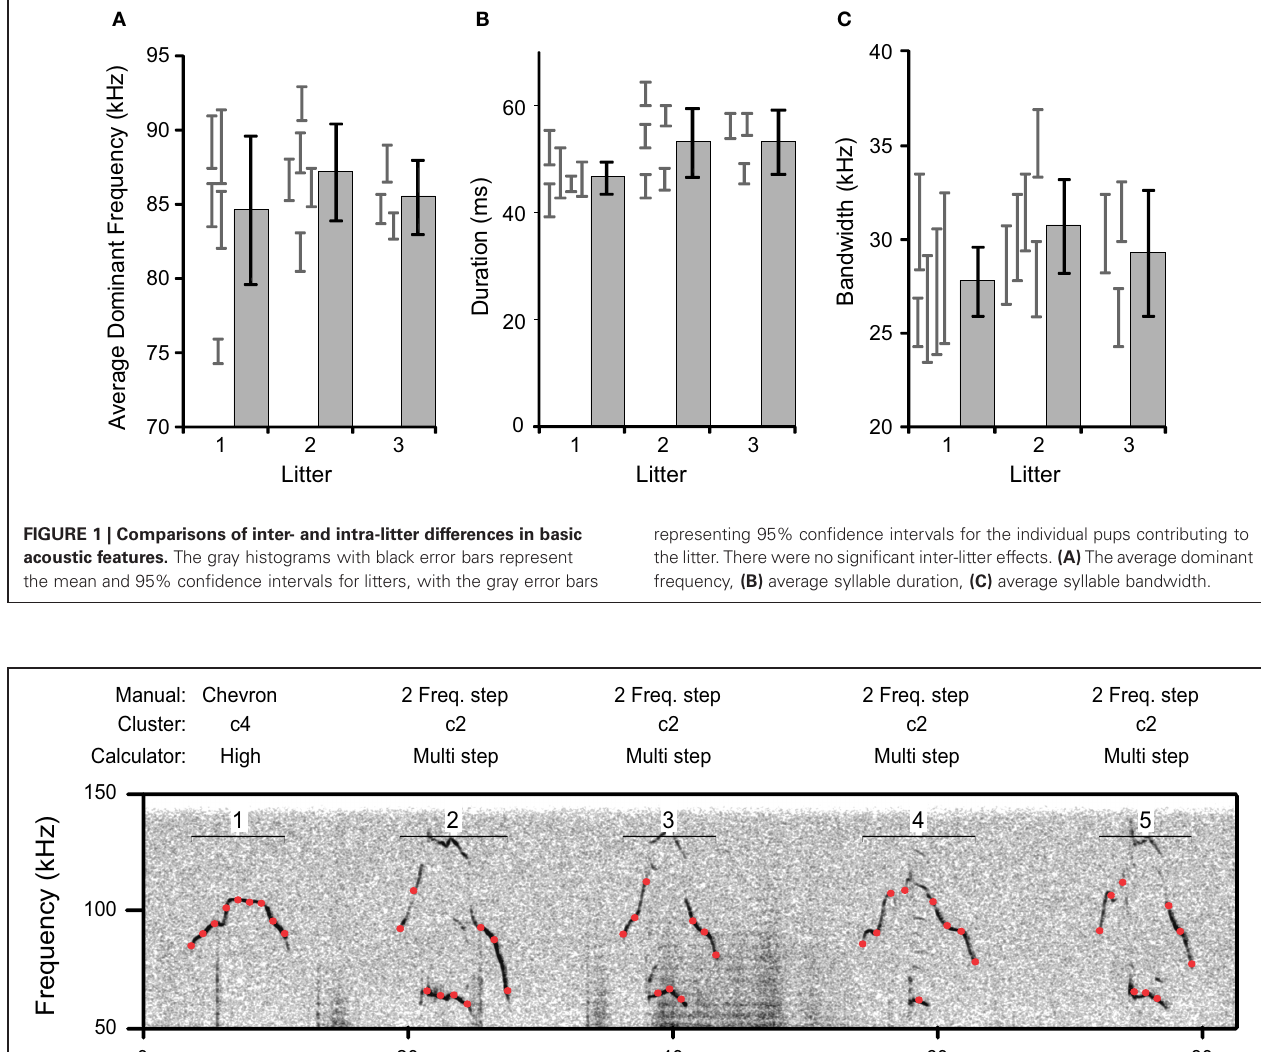
the classification of these syllables is shown by manual classification, cluster analysis, and the mouse call calculator. Syllables 2–5 have frequency